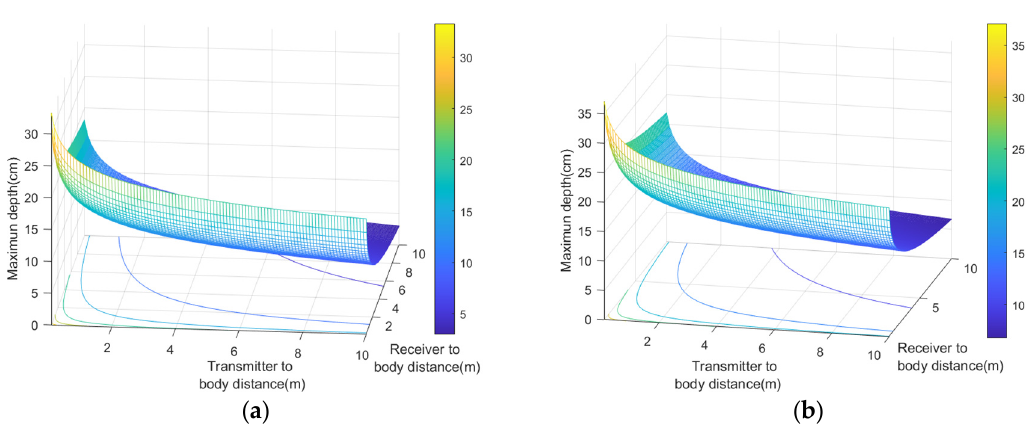
Figure 13. Simulated maximum depth for an implanted backscatter as a function of the distance of the transmitter and receiver from the body using the parameters of Table 2 for the bistatic case with a spreading factor SF = 7 ( a ) and SF = 12 ( b ). Propagation model parameters: n 1 = n 2 = 2.5, Fade Margin = 10 dB.